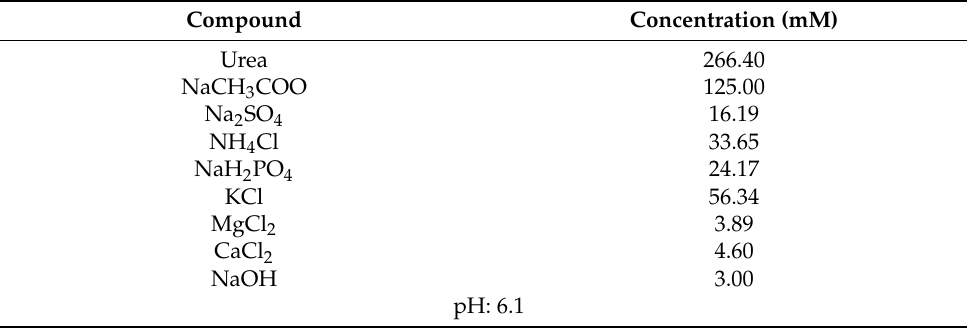
Table 2. Composition of the simulated urine 1